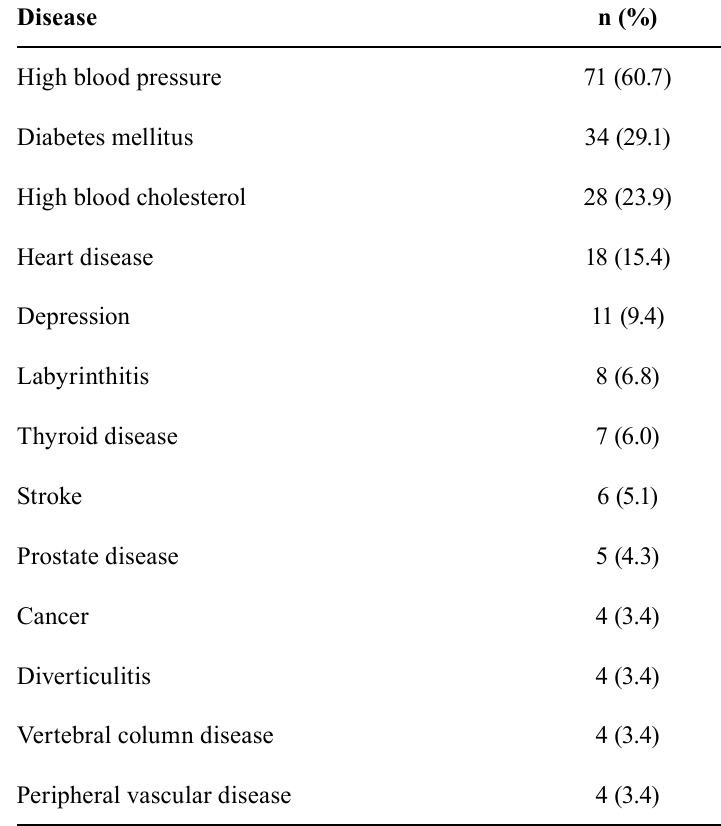
TABLE III – Simple and multiple logistic regression models predicting the appropriate recall of 100% of indications (N = 117)